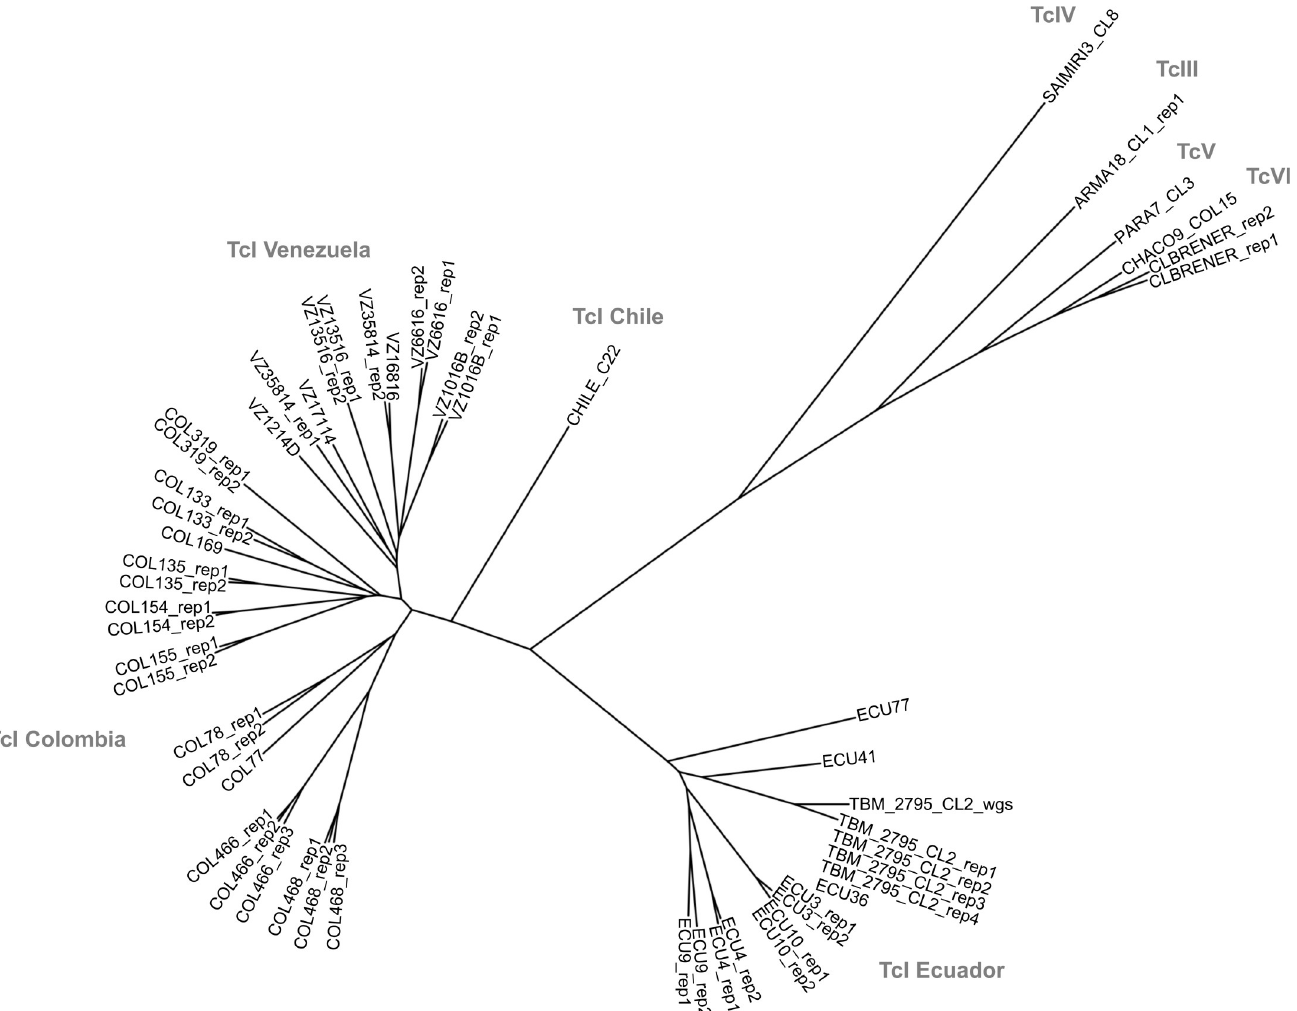
Fig 6. Neighbor-joining relationships among T . cruzi I samples and reference clones of other sub-lineages. Genetic distances are based on 556 biallelic SNP sites for which genotypes are called in all individuals. Results indicate high repeatability among most technical replicates (see ‘rep1–4’ suffices) and clearly separate TcI, TcIII, TcIV and TcV + TcVI. The tree also contains TBM_2795_CL2_wgs. This control sample was genotyped at the same 556 GLST loci using whole-genome sequencing (Illumina HiSeq) data from Schwabl et al . 2019 [1]. See S14 Fig for a tree with additional reference clones (genotypes generated in silico by subsetting WGS variant calls to GLST